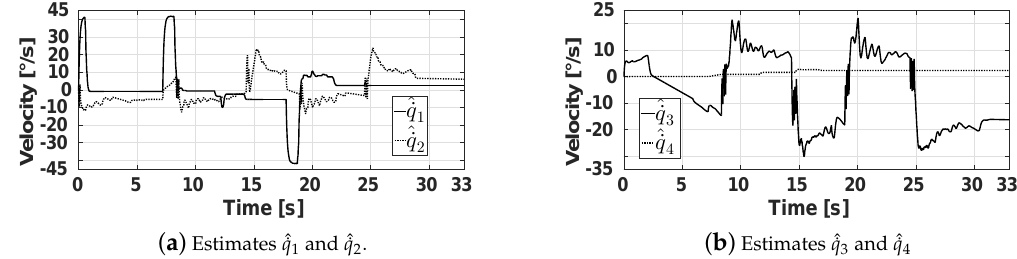
Figure 21. Estimates of the velocity joints provided by the state observers.